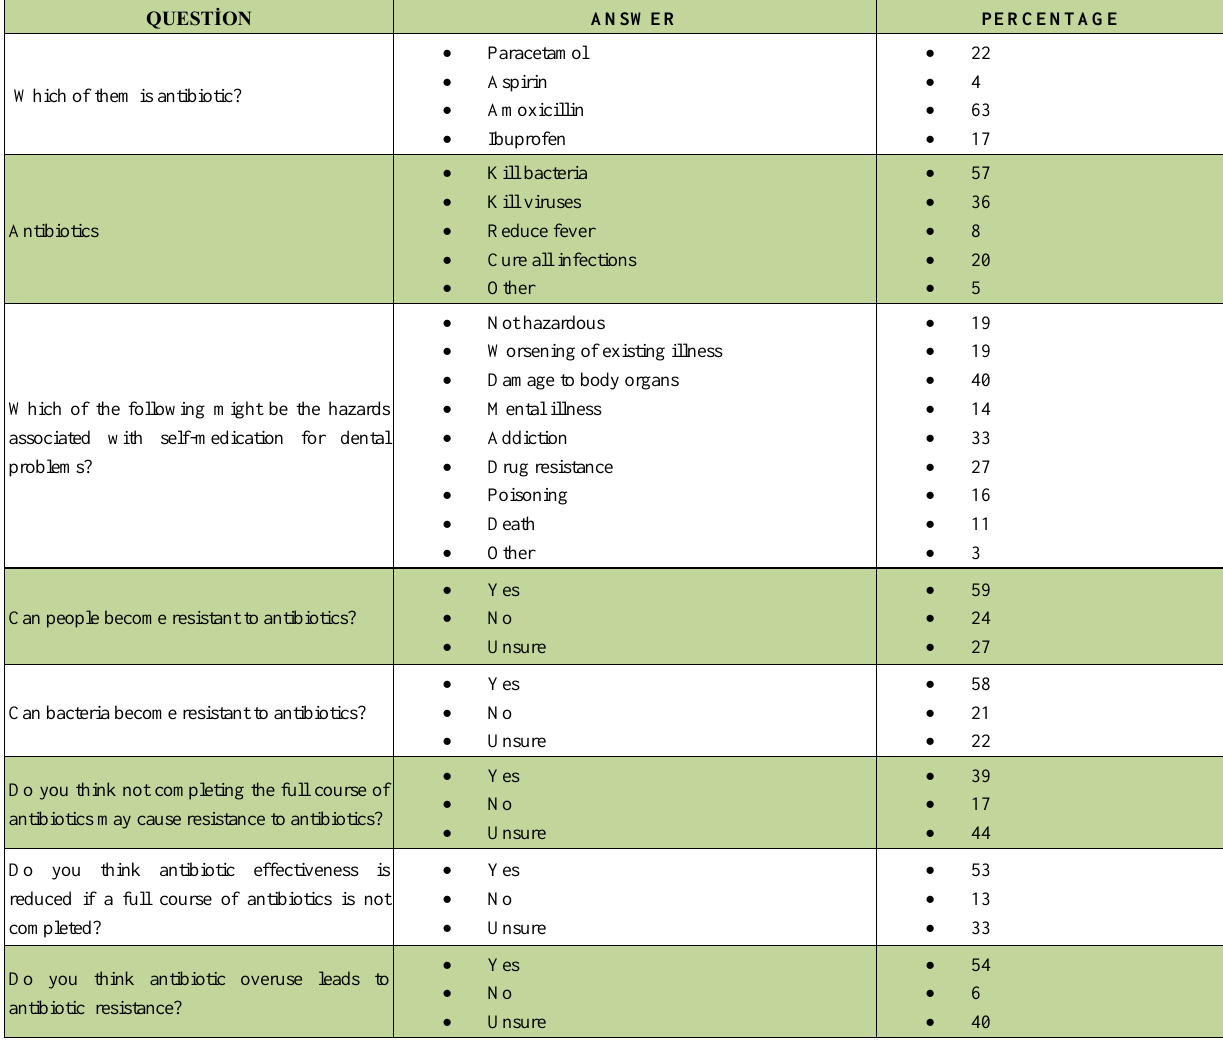
Table 2. Antibiotics efficacy, side effects, and